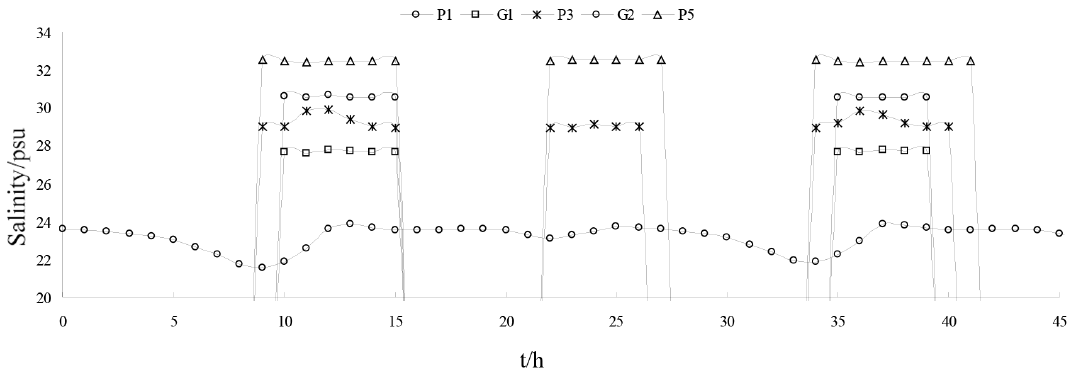
Figure 18. The simulated salinity concentrations at the five locations displayed in Figure 11.